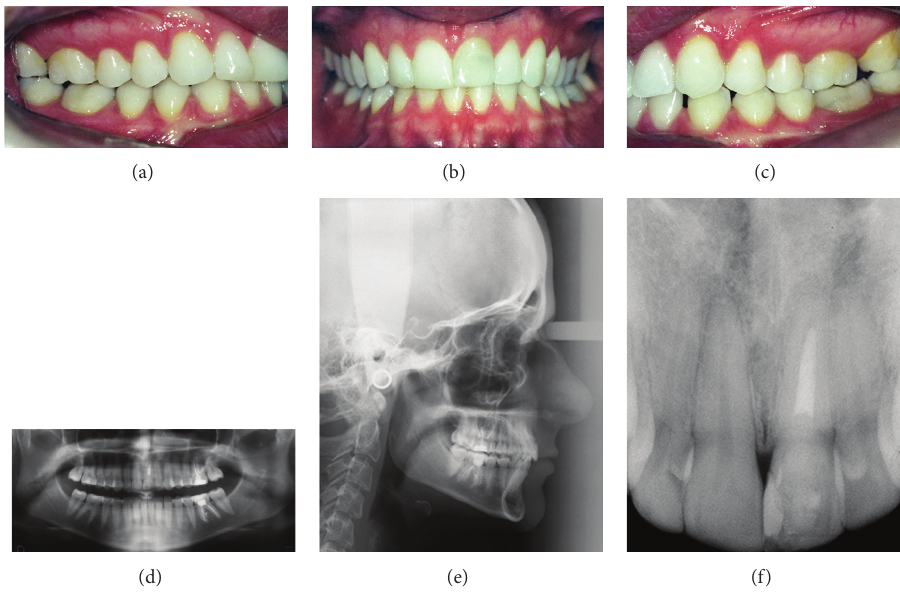
Figure 2: (a, b, c) Preoperative views; (d) panoramic radiography; (e) cephalometric radiography; (f) periapical radiography showing no significant changes to the maxillary left central incisor.